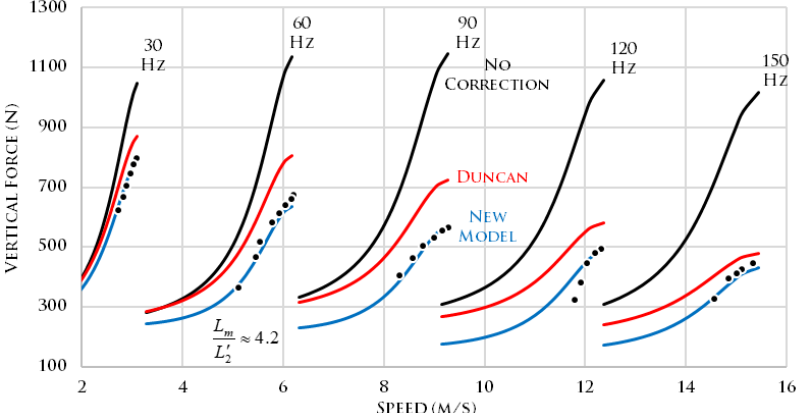
Figure 13. Comparison of vertical force through frequency variation (OD). Average gaps in ascending order [mm]: 1.86/2.15/2.21/2.32/2.35.